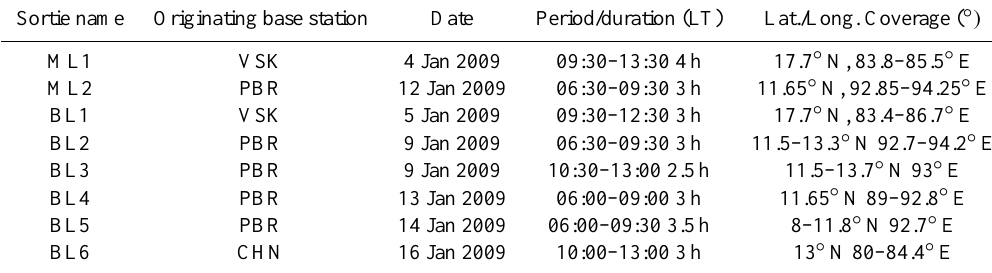
Table 2. Details of the ML and BL sorties and their spatial